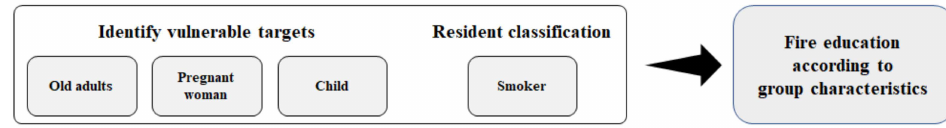
Figure 13. Reinforcing Safety Training for Fire Prevention.